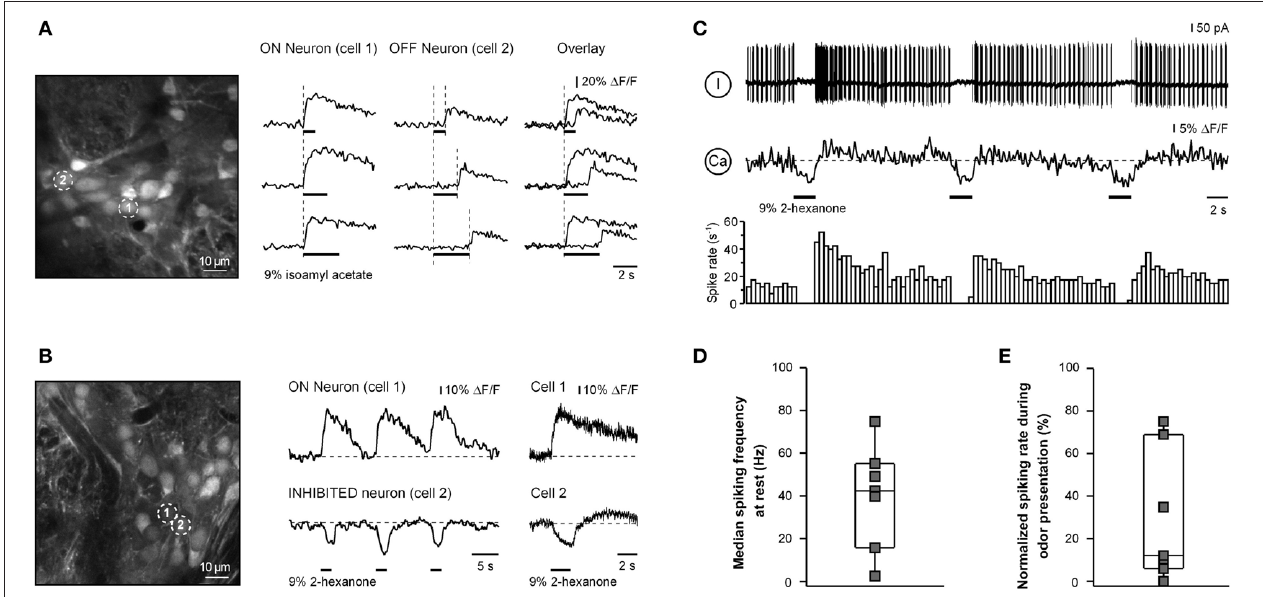
(ON response) while in cell 2 [Ca 2 + ] i decreases in response to the odorant presentation (INHIBITED response). The right panel shows responses of the two neurons in a subsequent trial sampled at a higher temporal resolution using the line scan mode (200Hz). Here and in (C) the odorant was 2-hexanone. (C) Simultaneous Ca 2 + imaging and loose-seal cell-attached recording from another neuron with an INHIBITED response. The top trace is the loose-seal cell-attached recording, the middle trace is the calcium signal, and the bottom trace is the peristimulus time histogram. (D) Box plot illustrating median background spike frequencies of neurons with inhibited responses to odorants measured prior to odorant presentation ( n = 7). (E) Box plot illustrating the odorant-induced reduction in spike frequency of the same seven cells. The odorant concentration was 9% of saturated